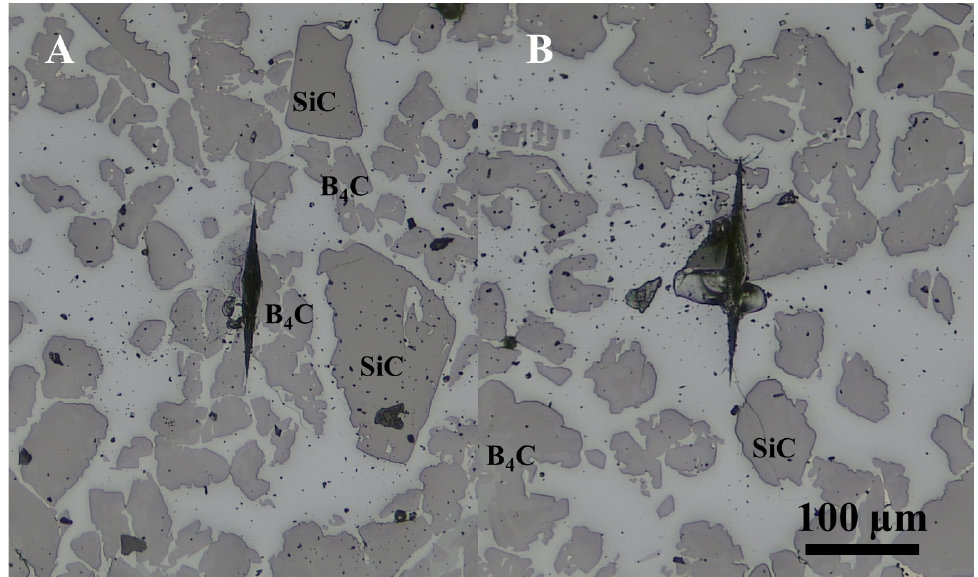
Figure 9. Optical images of Knoop indents on the SiC-B 4 C-Si composite showing ( A ) a mostly clean indent on the B4C and ( B ) an indent on the side of a SiC particle that experienced more deformation in the Si matrix.